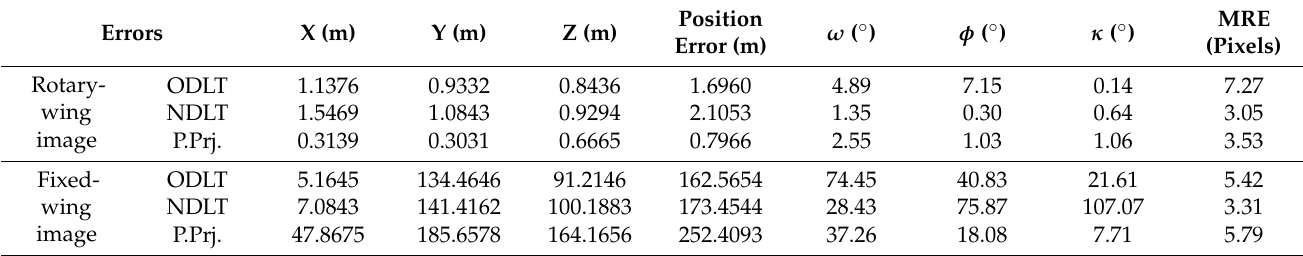
Table 7. Estimated EOP and reprojection errors of UAVs.